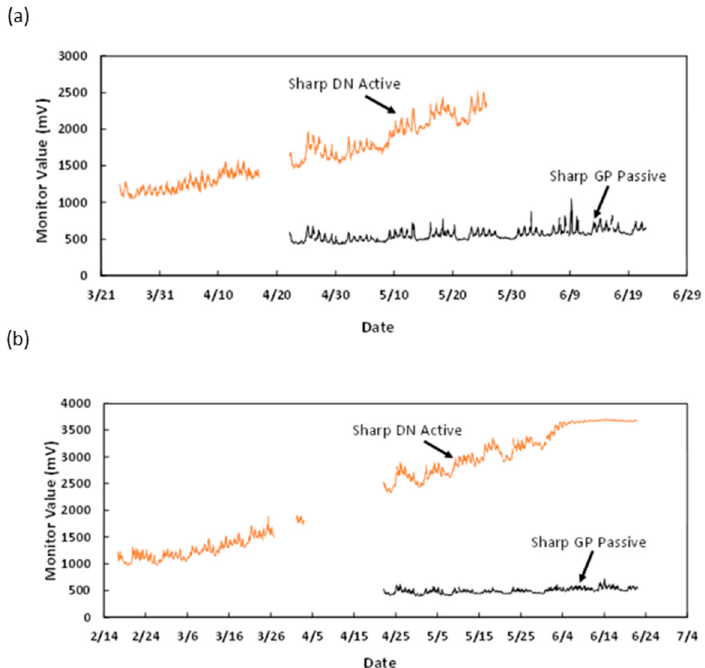
Figure 10. The accumulation of dust on the active Sharp sensors caused the readings to drift upward over time. ( a ) One example pair of collocated active and passive sensors; and ( b ) a second pair of collocated active and passive sensors in which the active sensor signal eventually flatlines. The passive version of the sensors seemed to suffer much less drift. Gaps in the graph represent periods when data were not recorded from the devices.